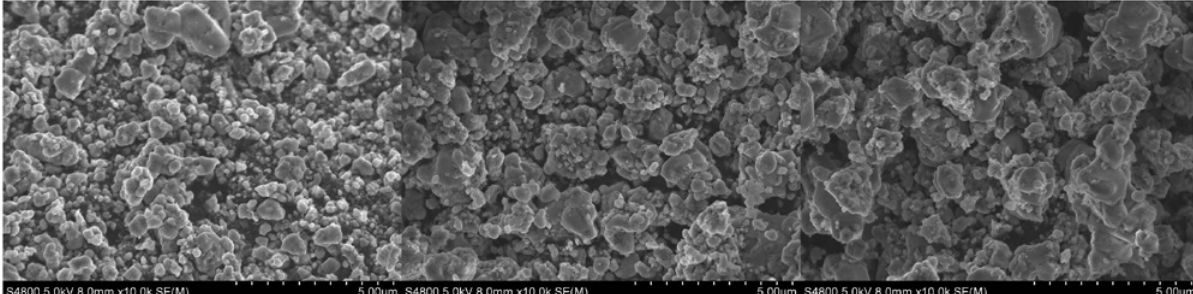
Figure 2: The SEM photos of PS (left), RS (middle), and MAS (right).